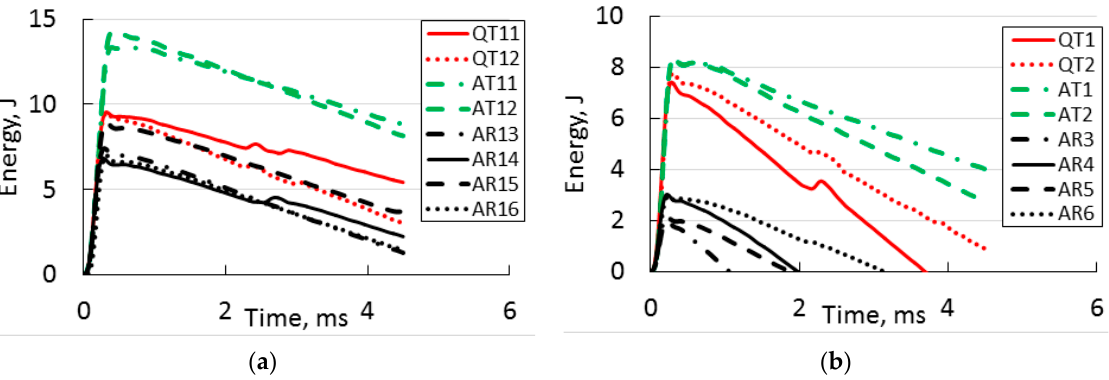
Figure 15. Comparison of Charpy impact toughness for AR, QT, and AT specimens. ( a ) standard V ‐ type notch and ( b ) sharp I ‐ type notch.